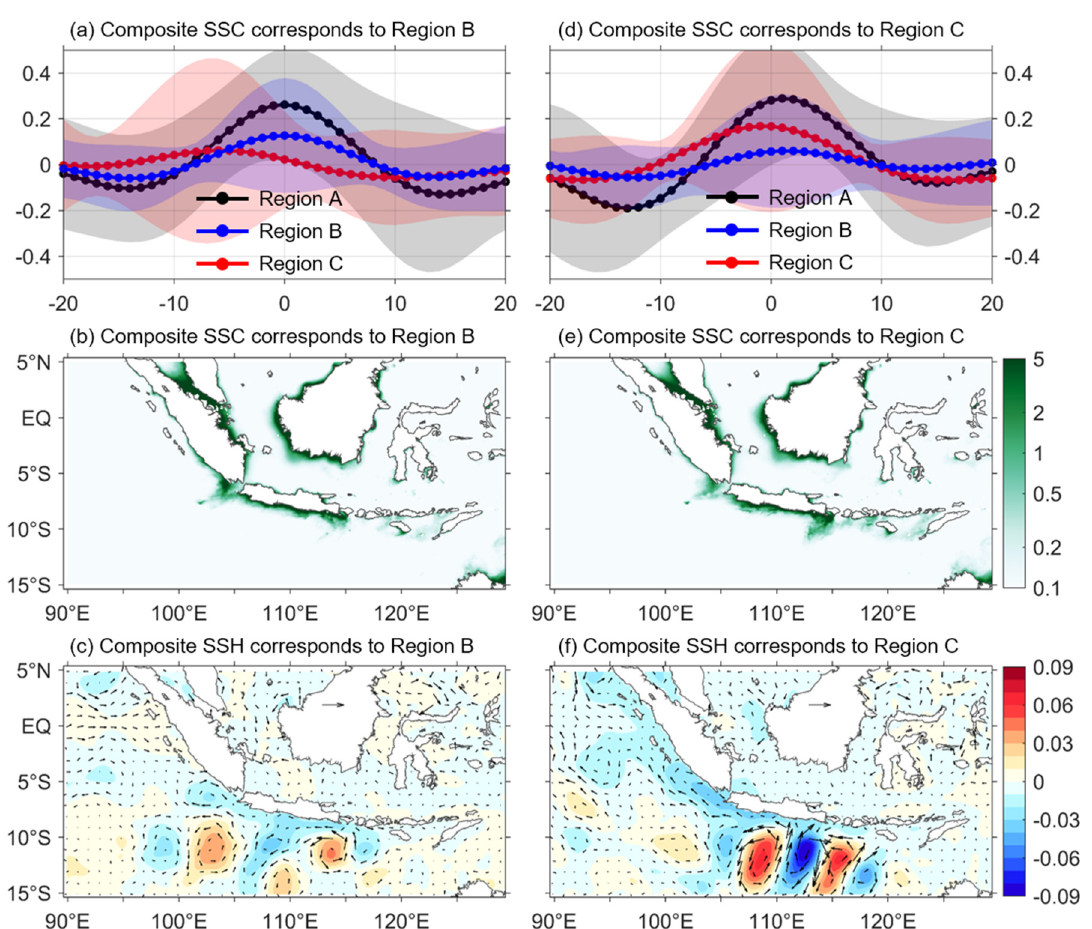
Figure 9. ( a ) Composite intraseasonal SSC averaged south of the Sunda Strait (Region B), and corresponding intraseasonal SSC averaged along the south coast of Java Island (Region B) and south of the Lombok Straits (Region C); ( b ) composite SSC distribution at the peak of the positive phases of intraseasonal SSC in Region B; ( c ) same as ( b ) but for intraseasonal SSH (shaded) and sea surface geostrophic currents (vector); ( d – f ) same as ( a – c ) but for the intraseasonal SSC averaged south of Lombok Strait (Region C). The intraseasonal time series are extracted from raw data during the period of 1 January 1998 to 31 December 2019 by employing a 20–90-days bandpass filter. Light shadings in ( a , d ) indicate the standard deviation of the composite intraseasonal SSC in regions A (gray), B (blue), and C (red).